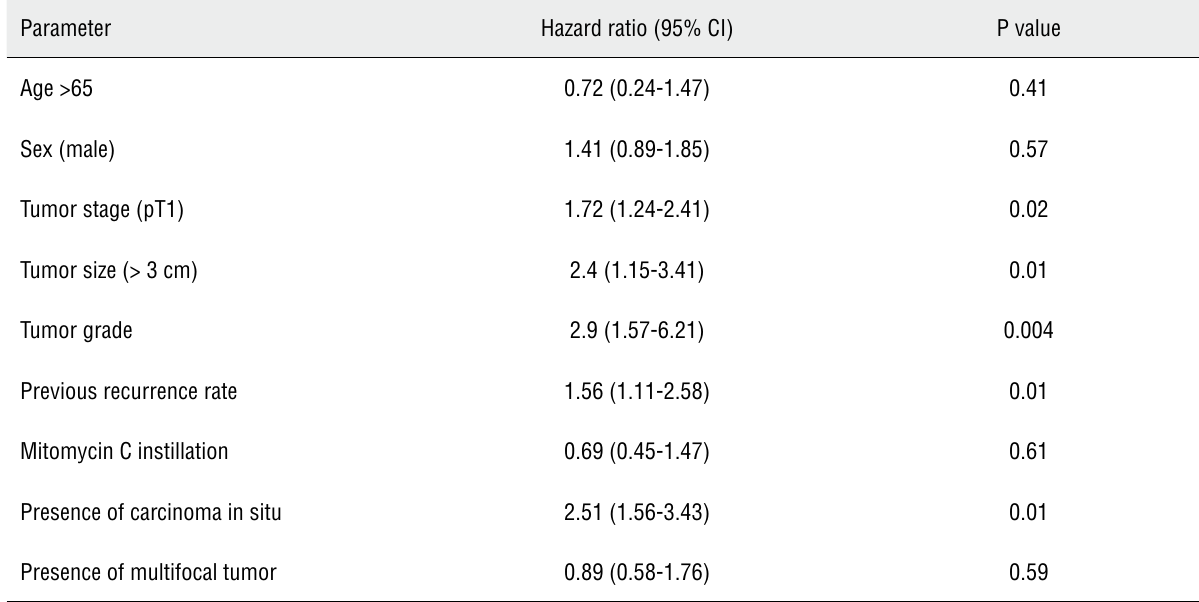
table 2 - Multivariate analysis for recurrence.